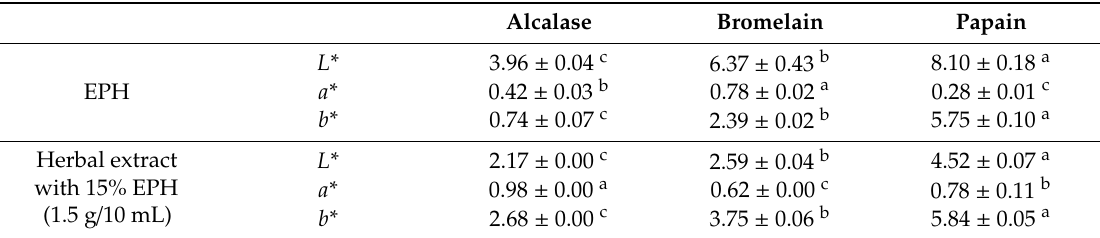
Table 4. Color analysis of the three EPHs (alcalase, bromelain, and papain) at concentration of 15% (1.5 g / 10